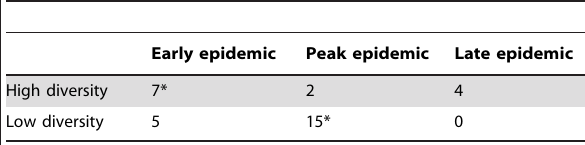
Table 2. Significant differences in nucleotide diversity between intraseasonal